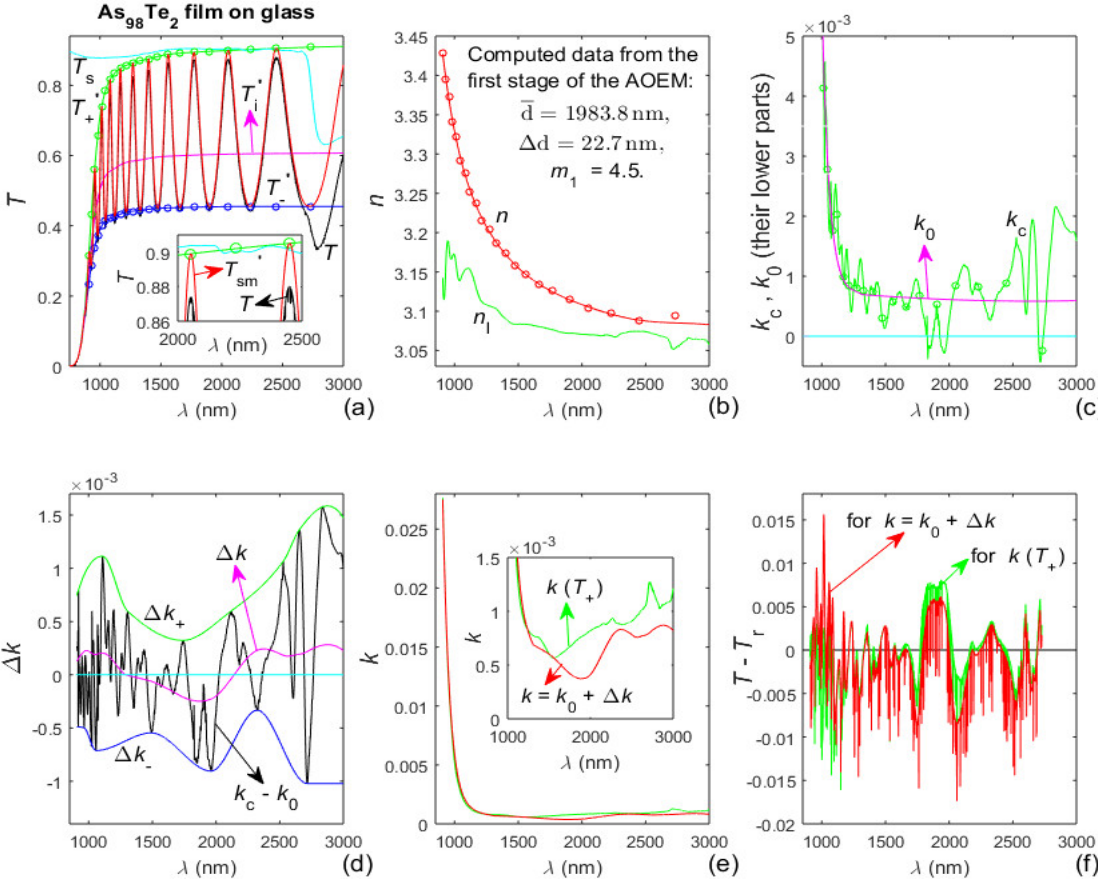
Figure 4. Input data and computed results from the characterization of the As 98 Te 2 film by the AOEM. ( a ) T s ( λ ), T ( λ ), T sm ( λ )’, its envelopes T + ( λ )’ and T − ( λ )’, the points T + ( λ t )’ and T − ( λ t )’ represented by circles, and T i ( λ )’; ( b ) n 0 ( λ t ) shown by circles, n ( λ ), and its lower limit n l ( λ ); ( c ) k c ( λ ) and its optimized curve fitted k 0 ( λ ); ( d ) deriving the partially coherent light correction Δ k ( λ ); ( e ) k ( T + ) computed from Equation (2) and k = k 0 + Δ k ; and ( f ) difference between T ( λ ) and T r ( λ ) computed using k ( T + ) and k = k 0 + Δ k , respectively.